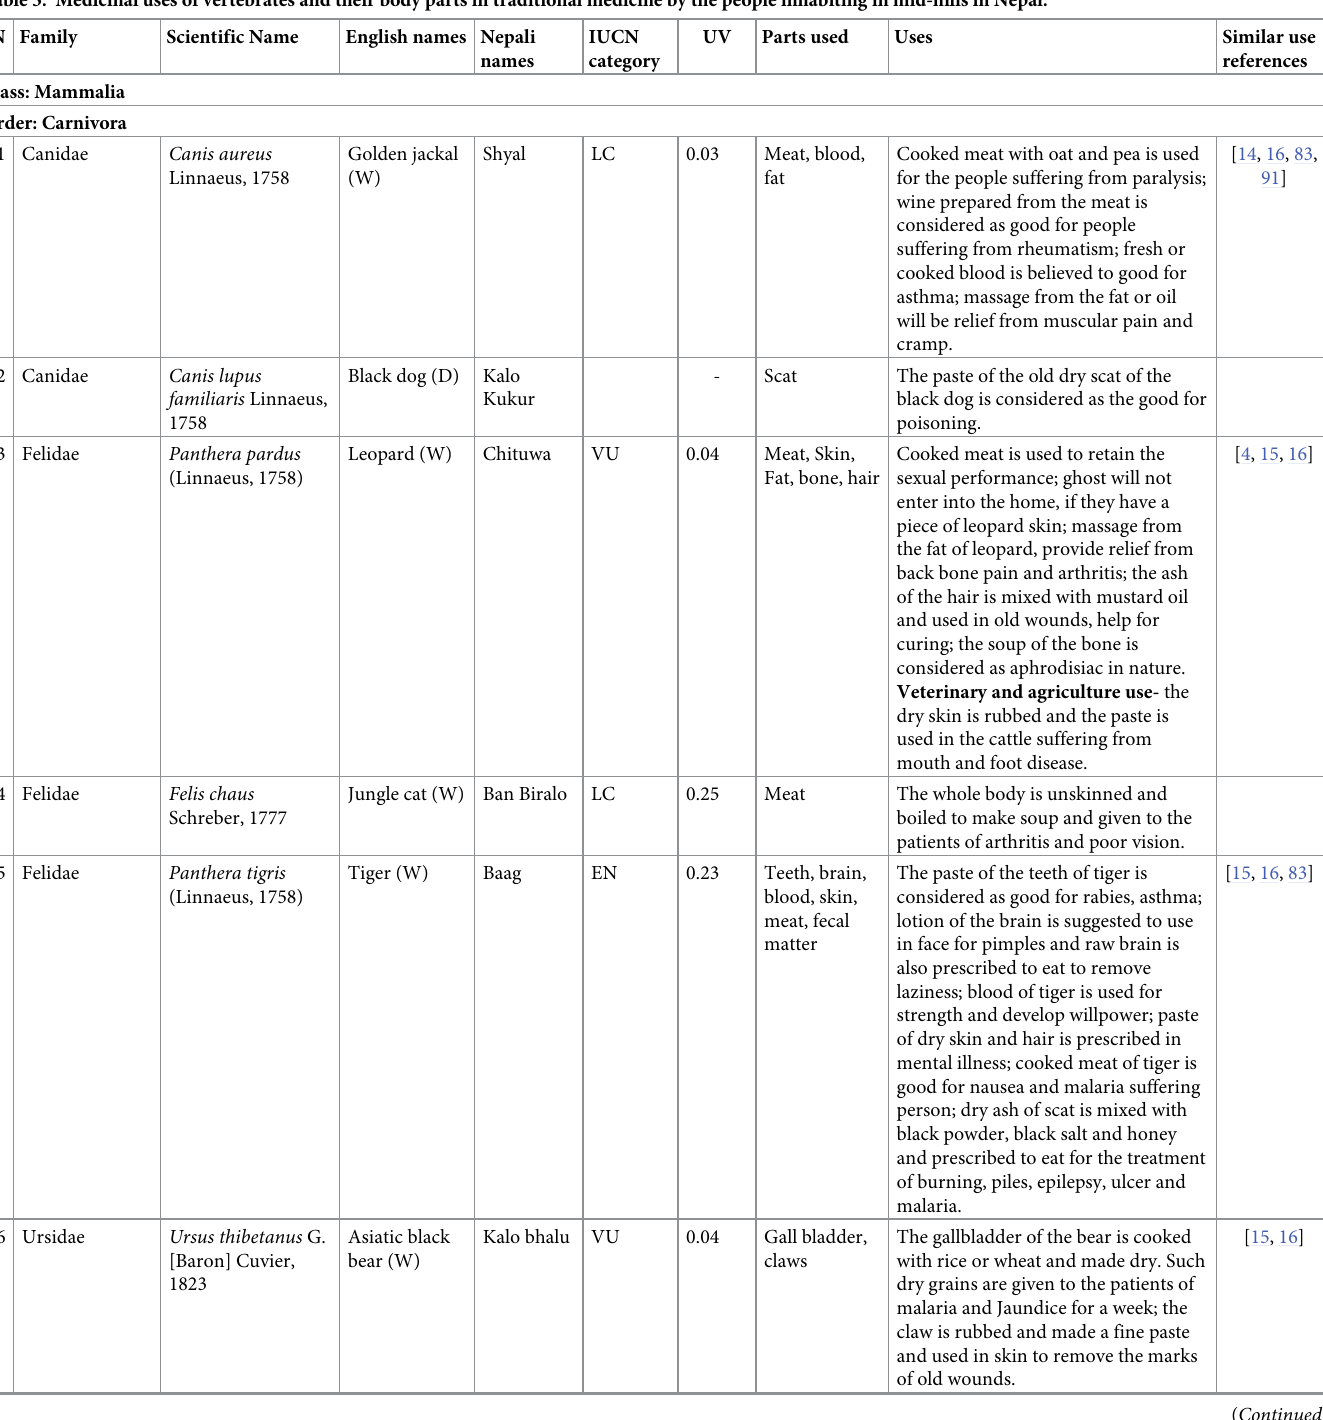
Table 3. Medicinal uses of vertebrates and their body parts in traditional medicine by the people inhabiting in mid-hills in Nepal. SN